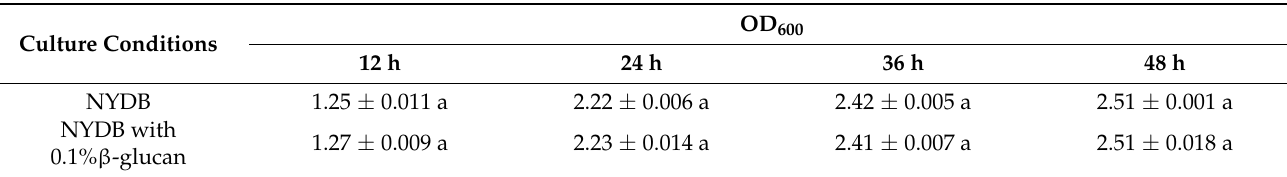
Table 2. Growth of S. spartinae W9 in NYDB or NYDB containing 0.1% β